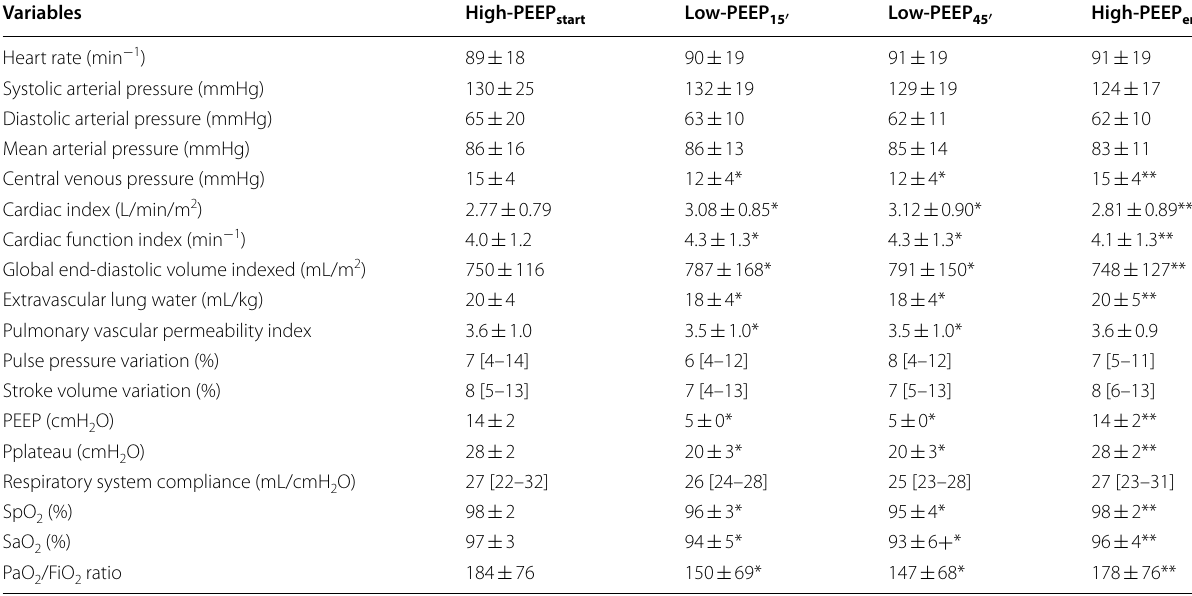
Table 2 Haemodynamic and respiratory variables